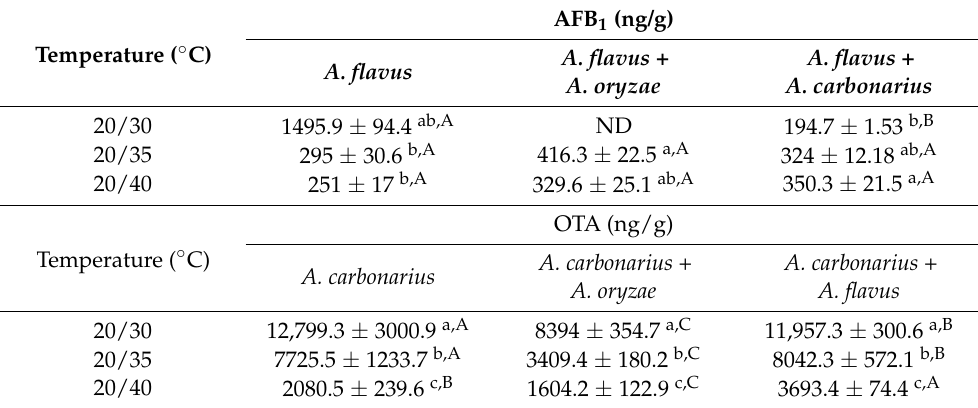
Table 2. AFB 1 and OTA production (ng/g) of A. flavus and A. carbonarius in single and mixed cultures at fluctuating temperatures on CCA. AFB 1 (ng/g) Temperature ( ◦ C) A. flavus + A. flavus A. oryzae 20/30 1495.9 ± 94.4